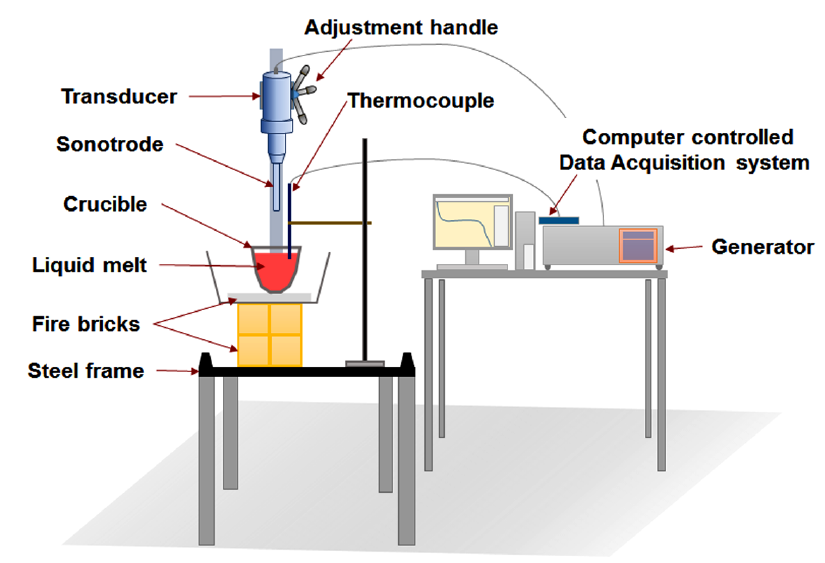
Figure 1. Ultrasonic treatment (UST) platform (steel frame) shows the arrangement of a crucible containing liquid melt placed over fire bricks. The adjustable handle is used to lower the sonotrode into the melt when the required temperature is recorded by the data acquisition system (K-type thermocouple). Table 1. List of the experiments undertaken at The University of Queensland (UQ) and allied research groups at RMIT University and Helmholtz-Zentrum Geesthacht